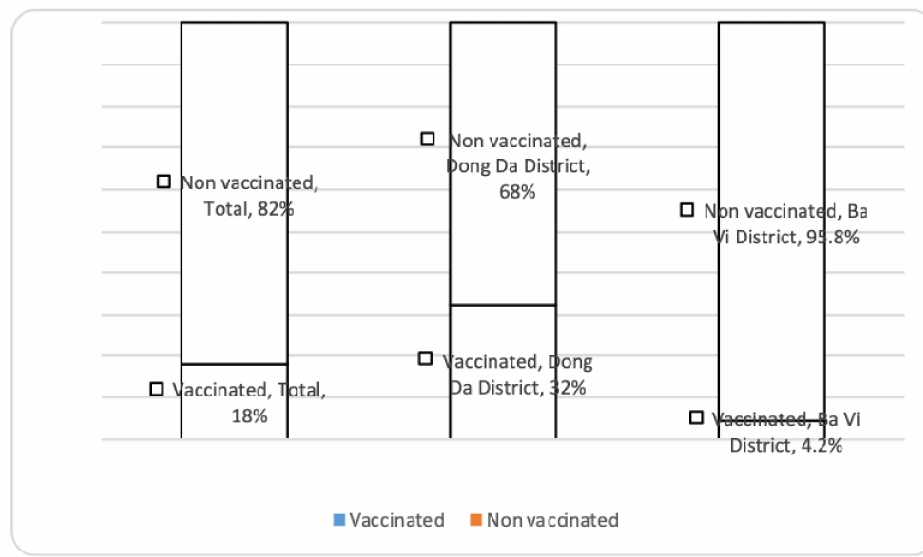
Figure 1. Rubella vaccination coverage before